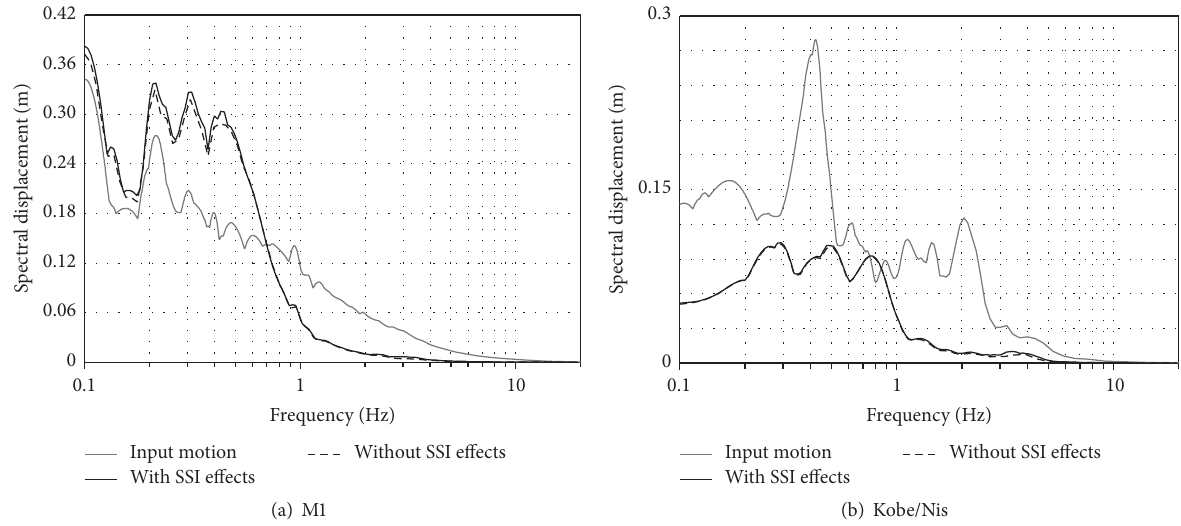
Figure 7: Comparison of the response spectral displacements for the top of the Reactor Containment Building and input motion.